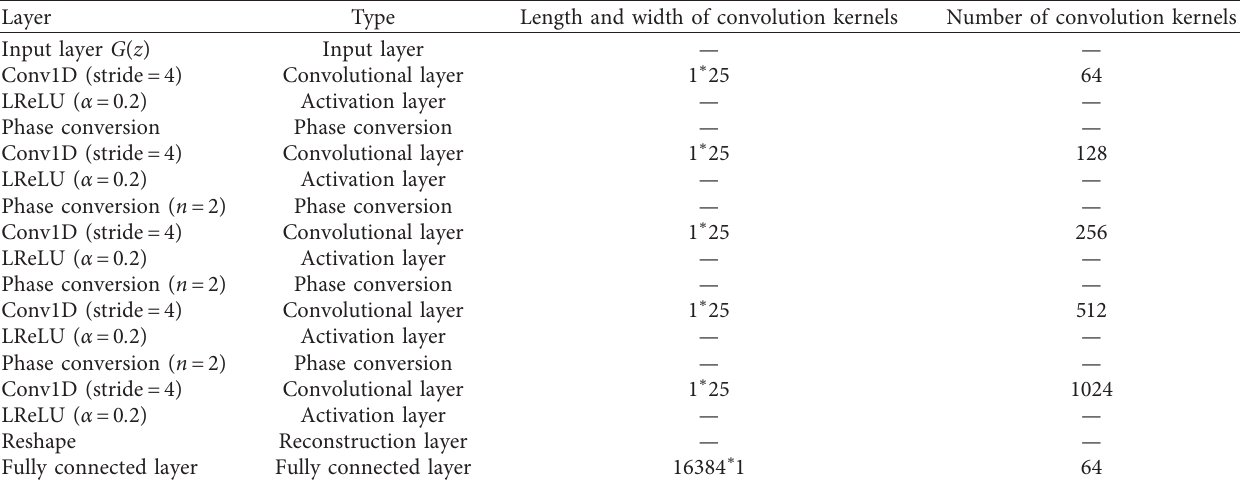
Table 2: Discriminator structure of the raw audio GAN model.